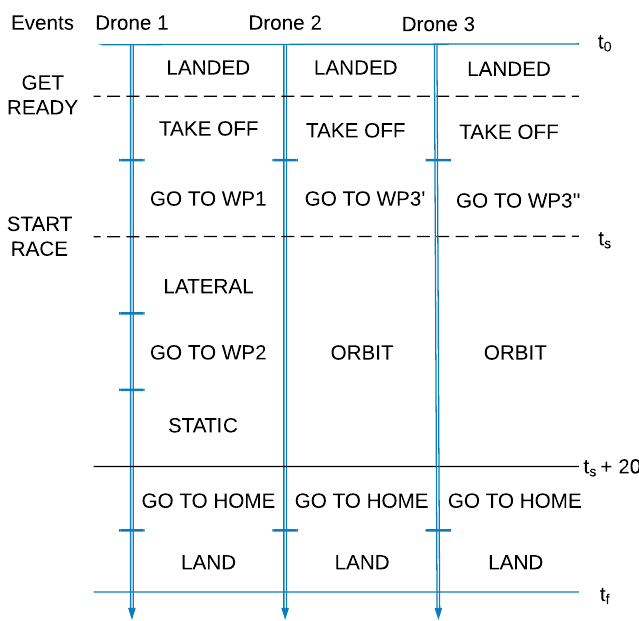
Figure 10. Execution of the example mission. WP1, WP2, WP3’, and WP3” are drone start positions for SA1, SA2, SA3’, and SA3”, respectively.